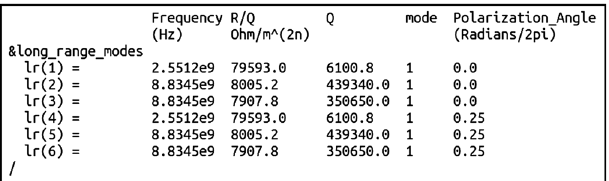
FIG. 9. An example file of three dominant horizontal HOMs (the top 3) and three identical vertical HOMs (the bottom 3) assigned to a single CBETA MLC cavity. The HOMs are simulated using HTC program with ϵ ¼ 125 μ